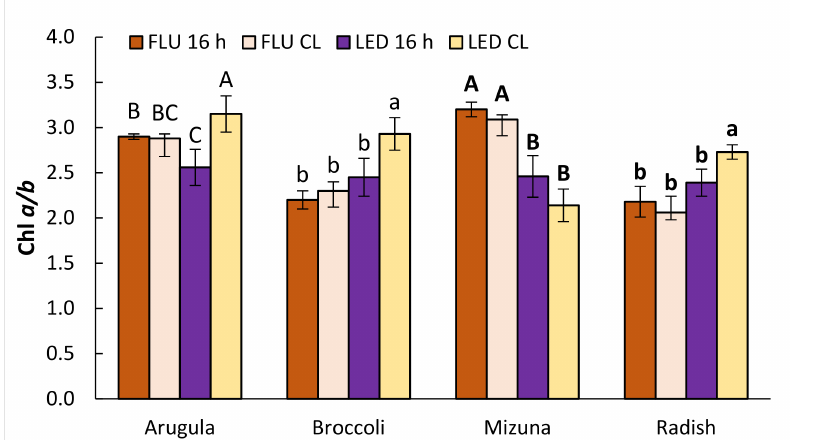
Figure 2. Chl a/b ratio of arugula, broccoli, mizuna, and radish microgreens grown under 16 h photoperiod or CL provided by fluorescent (FLU) or LED lamps. The results are presented as the mean ± standard error. Different letters for each parameter and plant species indicate significant differences between the mean values at p < 0.05.